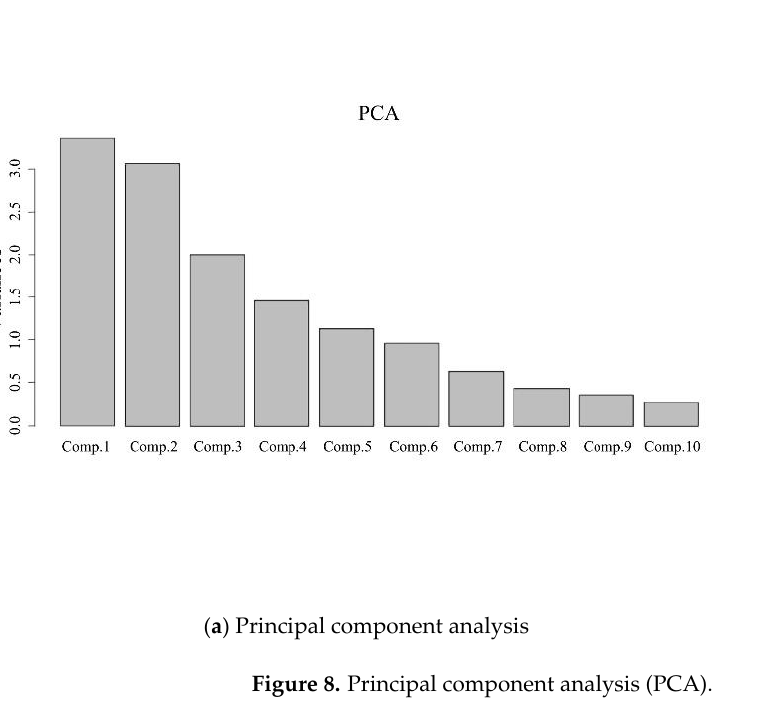
Figure 8. Principal component analysis (PCA).